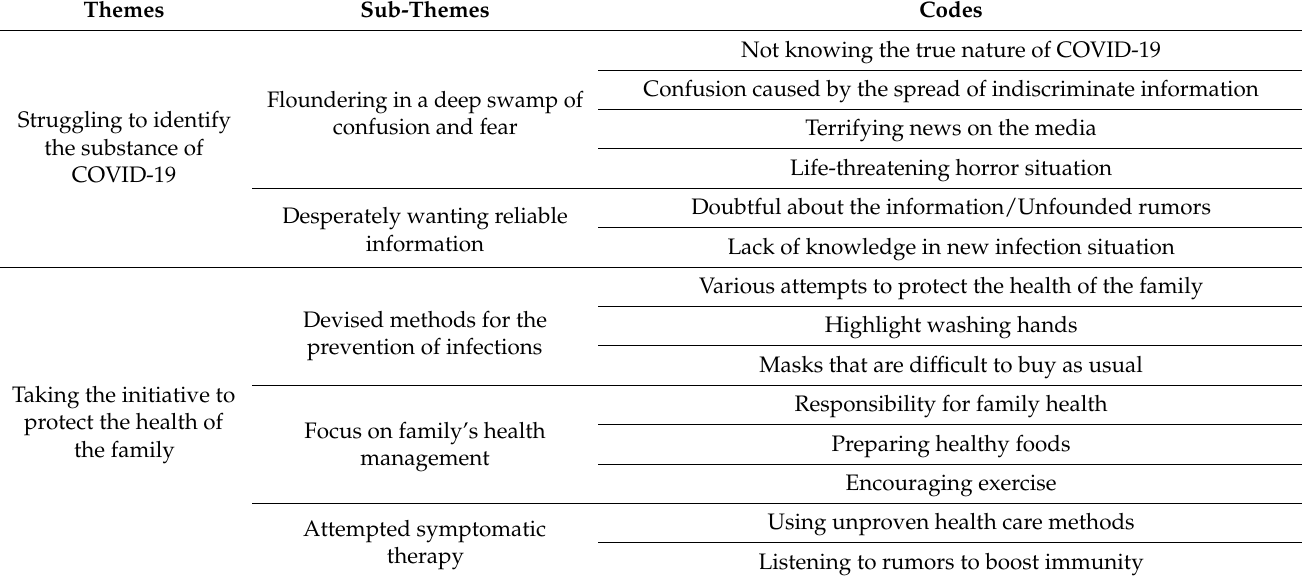
Table 3. Life-changing experiences of mothers with school-age children during the COVID-19 pandemic ( N = 12).